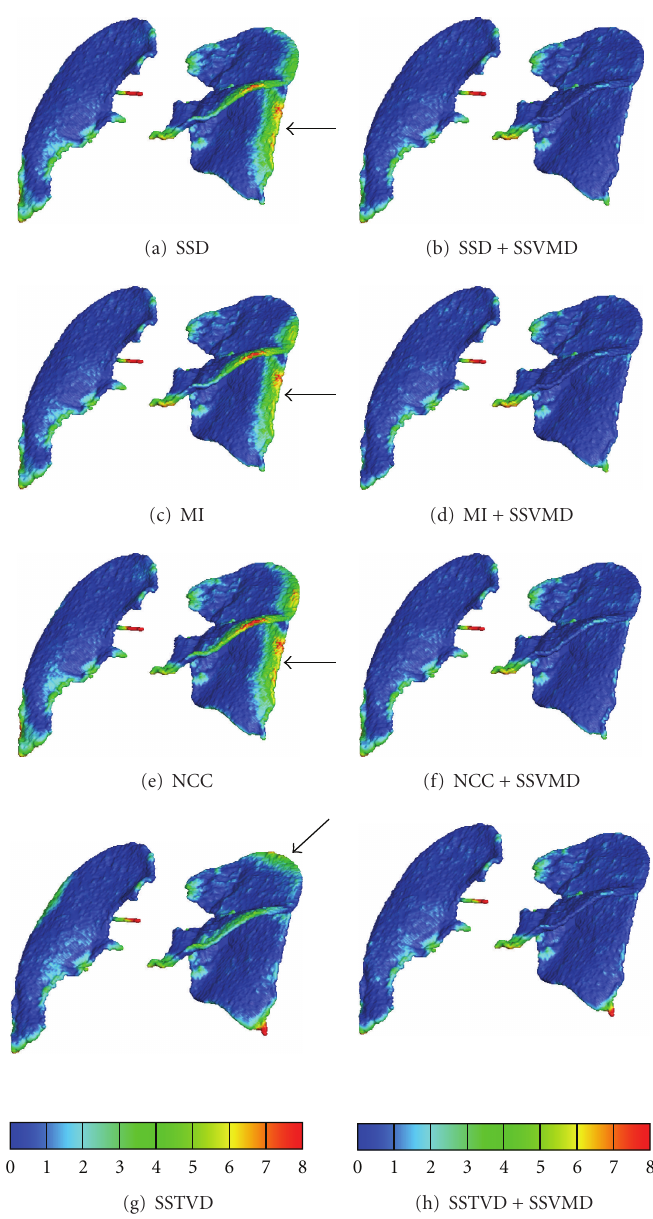
Figure 8: Fissure positioning error (mm) on fissure planes. Arrows denote regions of large discrepancies between the deformed source and target fissure